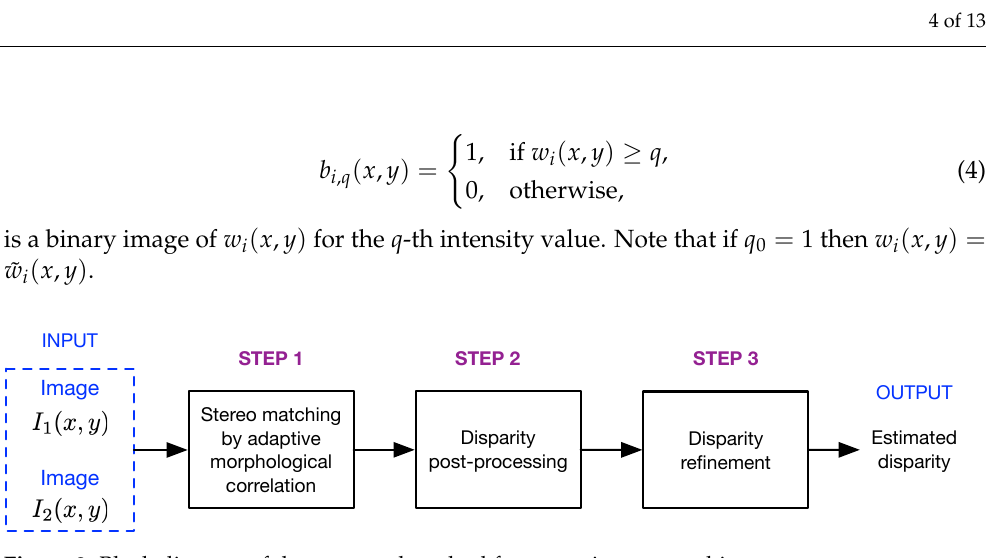
Figure 2. Block diagram of the proposed method for stereo image